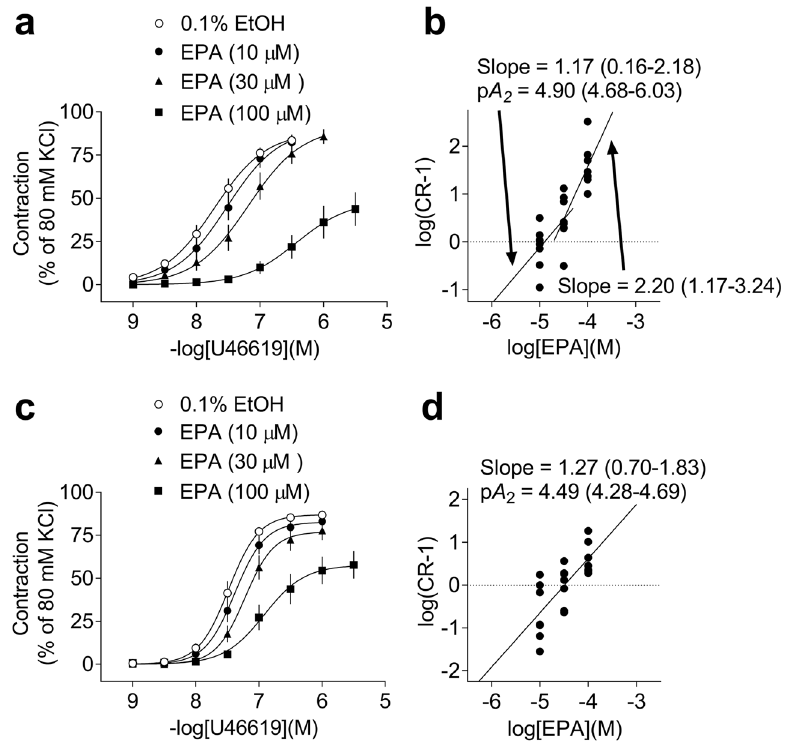
Figure 7. Quantified data of inhibitory effects of 10–100 μM eicosapentaenoic acid (EPA) on the concentration–response curves (CRCs) for porcine basilar ( a ) and coronary ( c ) artery contractions induced by U46619 and Schild plot analysis of EPA versus U46619 in porcine basilar ( b ) and coronary ( d ) arteries. CRCs are shown as mean ± SEM [n = 10 ( a ) and n = 8 ( c )] and Schild plots are shown as individual data points [n = 24 ( b ) and n = 21 ( d )]. The slope and p A 2 values are shown as means with 95% confidence